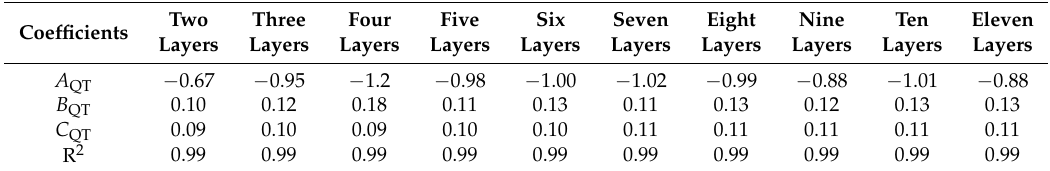
Table 5. Fitting parameters for the total charge quantity at steady state (1800 s) under different temperatures for multi-layer oil-paper insulation.